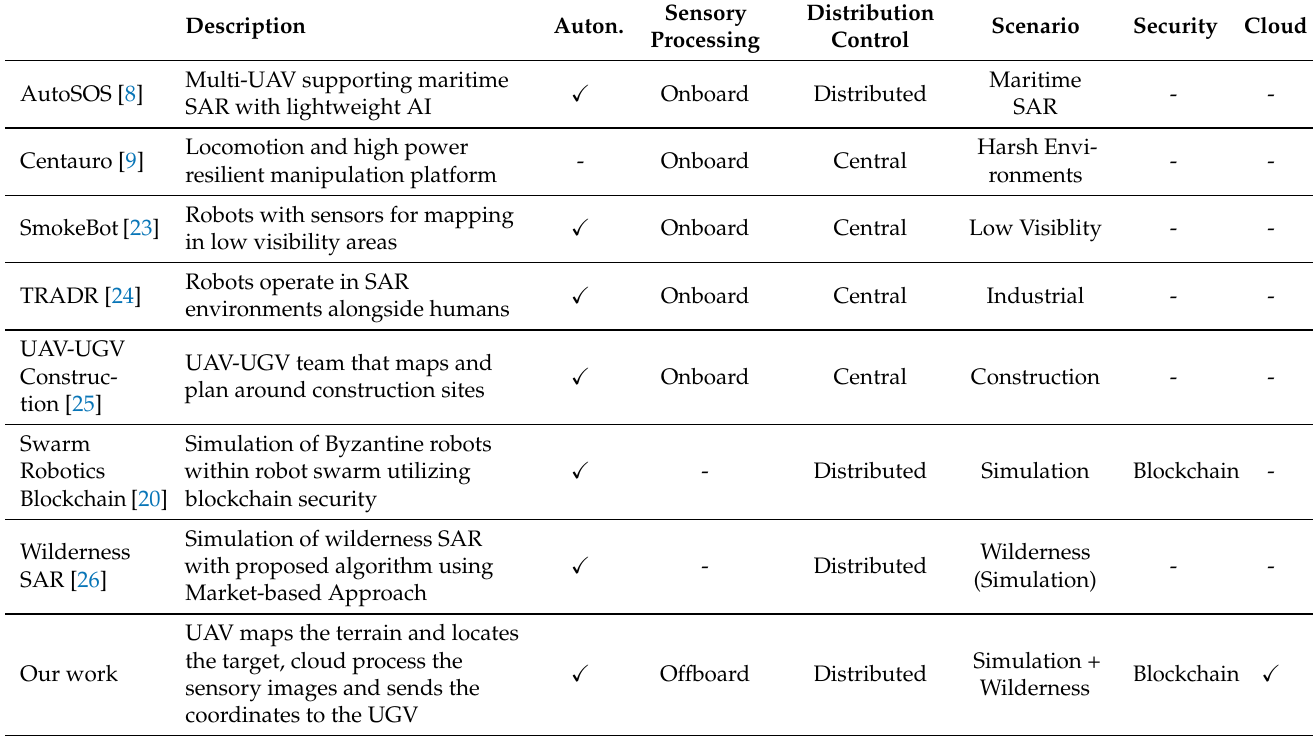
Table 1. This is a comparison of work carried our in Search and Rescue (SAR) Robotics. We compare the existing literature based on whether the system is autonomous or not, where the data are processed, and whether a cloud is involved. We compare the architecture of the system, i.e., whether it is distributed or centralized. The scenario categorizes what kind of SAR environment the work focused on. The security protocols used in different works are compared as